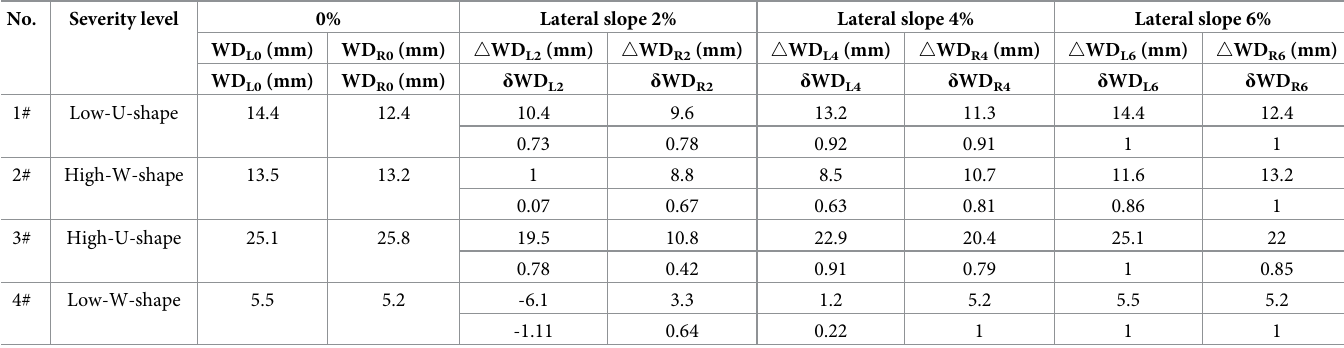
Table 2. Variation of the water-filled rut depth and its change